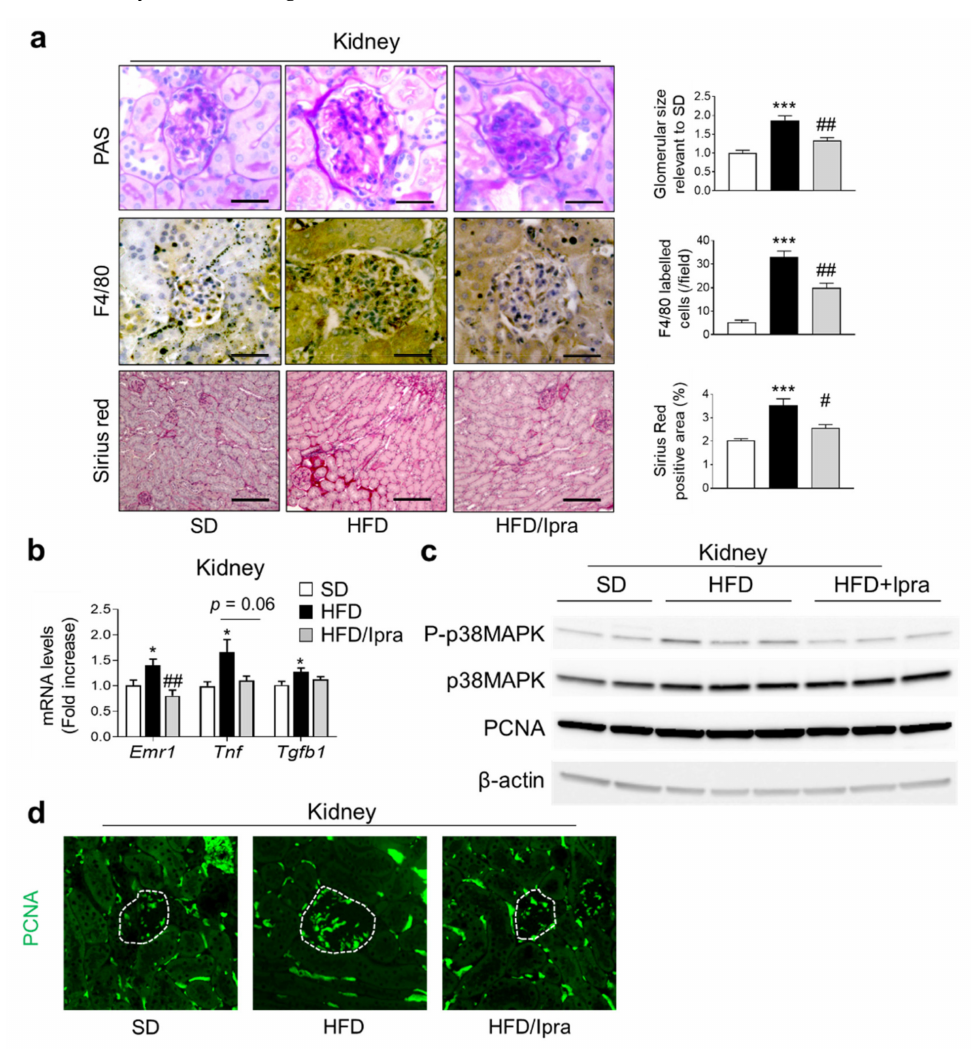
Figure 3. Ipra inhibits macrophage infiltration and proliferative signals in the kidney. ( a ) Representa- tive images and quantification of PAS staining, F4/80 immunostaining, and sirius red staining in kidney. ( b ) Expression levels of inflammation- and fibrosis-related genes in the kidney of SD- or HFD-fed WT mice after 6 weeks of Ipra treatment. ( c ) Representative blots of phosphorylated/total p38 mitogen-activated protein kinase (p38 MAPK) and PCNA in the kidney. ( d ) Representative pic- tures of fluorescent immunostaining of PCNA (green). Inside of dotted lines indicate the glomerular tuft areas. WT, wild-type; SD, standard diet; HFD, high-fat diet; Ipra, ipragliflozin; PRAT, perirenal adipose tissue. Scale bar, 50 µ m (PAS and F4/80), 250 µ m (Sirius red). * p < 0.05, *** p < 0.001 vs. SD. # p < 0.05, ## p < 0.01 vs. HFD. n =